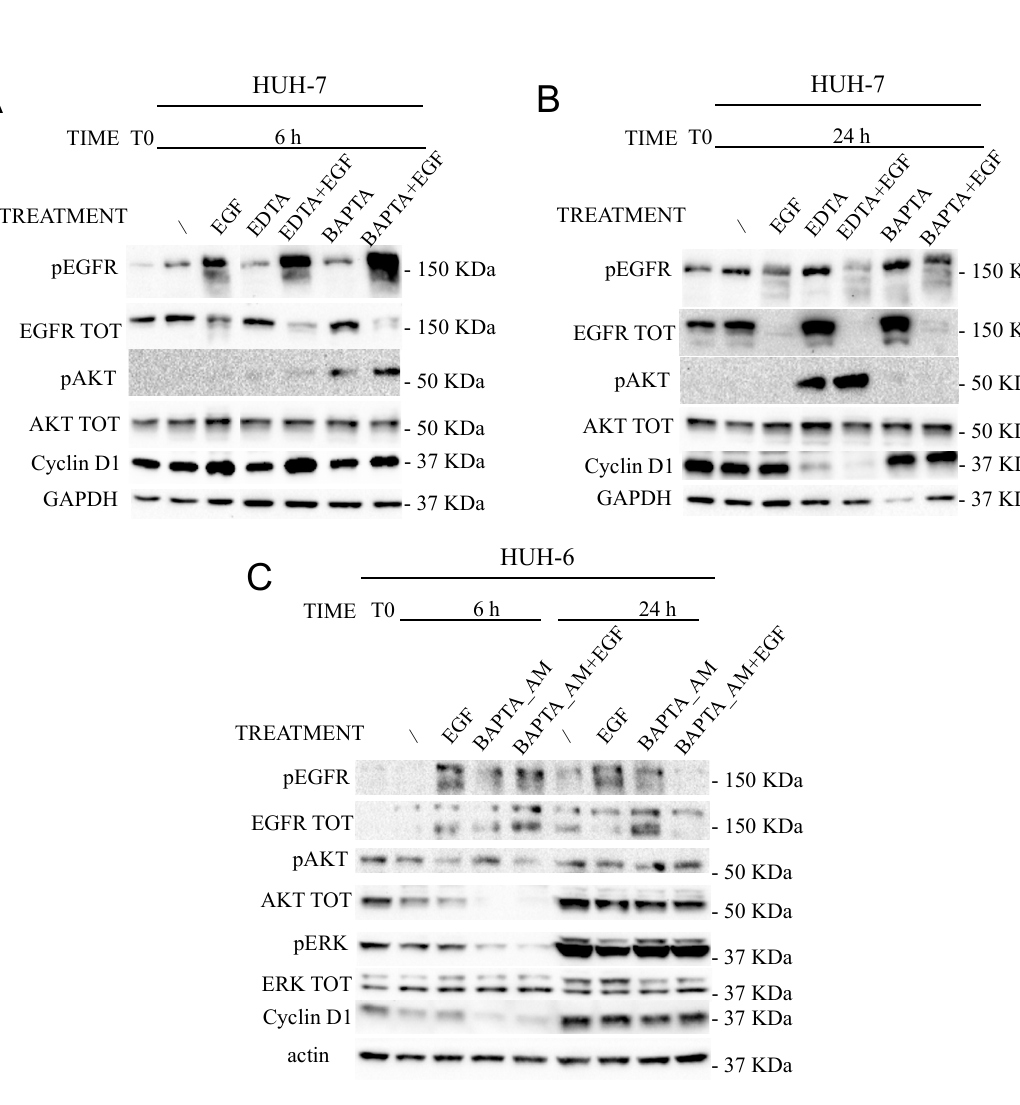
Figure 9. Starved HUH-7 ( A , B ) and HUH-6 cells ( C ) (T0) were left untreated (as CTR) or treated with 2 mM EDTA or 10 µM BAPTA_AM with or without 100 ng/mL EGF. The cell signaling cascade was analyzed by western blot after 6 h and 24 h.